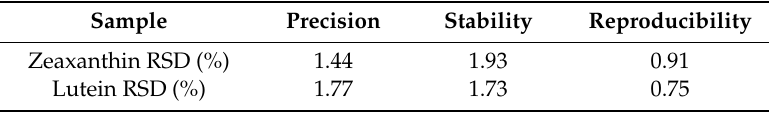
Table 1. Precision and stability experiments.